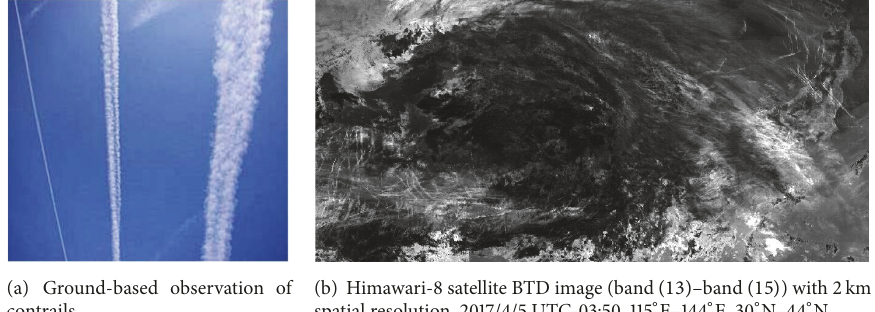
Figure 1: Contrails ground-based and satellite